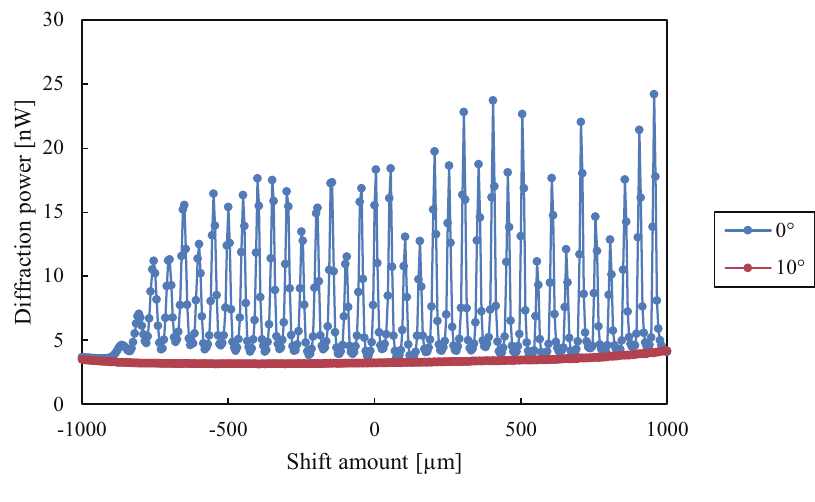
Figure 7. Rotational selectivity of shift multiplexed